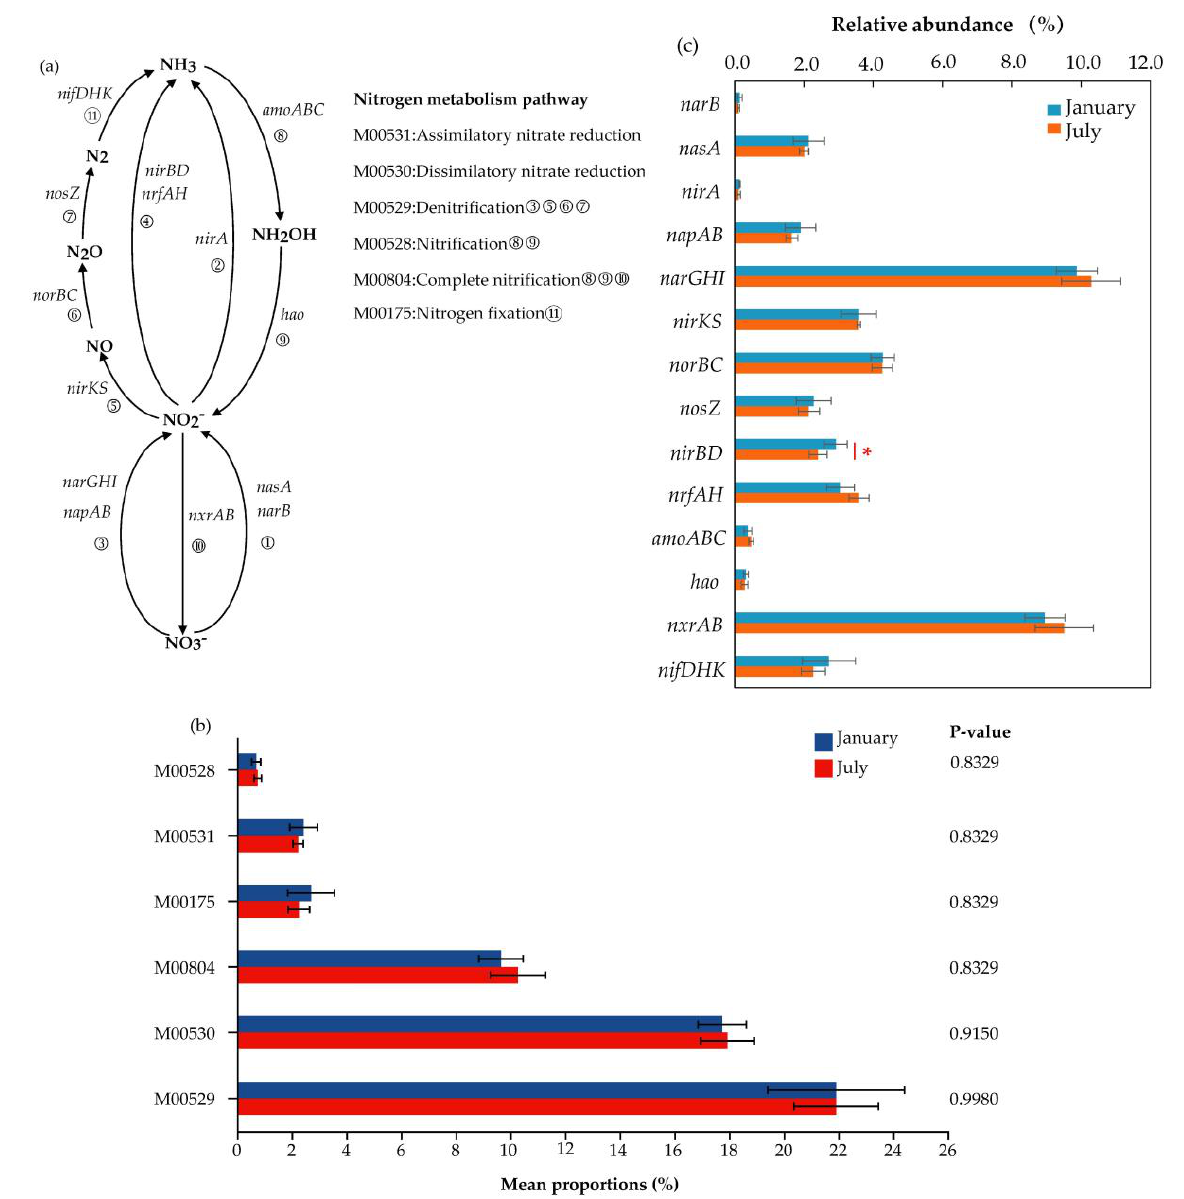
Figure 7. MSSFCW microbial nitrogen metabolism pathway and related functional genes: ( a ) KEGG pathway for nitrogen metabolism; ( b ) nitrogen metabolism pathway statistical test; ( c ) functional gene relative abundance histogram. * Indicates a significant difference between groups ( p < 0.05).